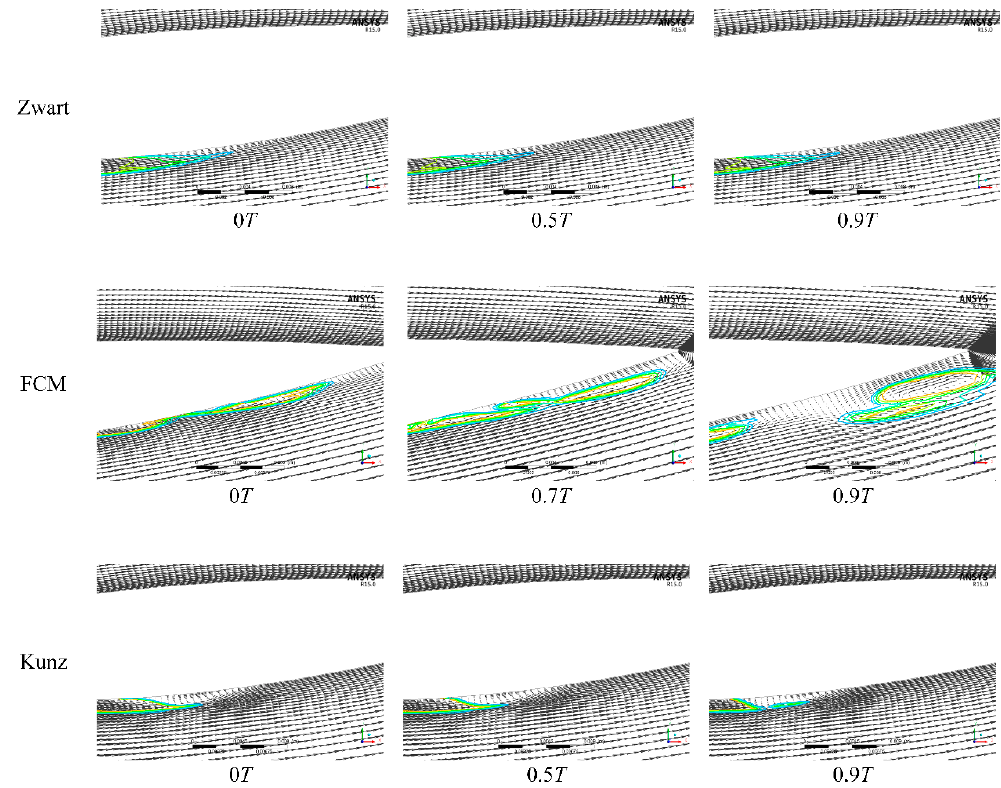
Figure 7. Velocity vector field predicted by three cavitation models ( σ = 1.075, α = 60°).